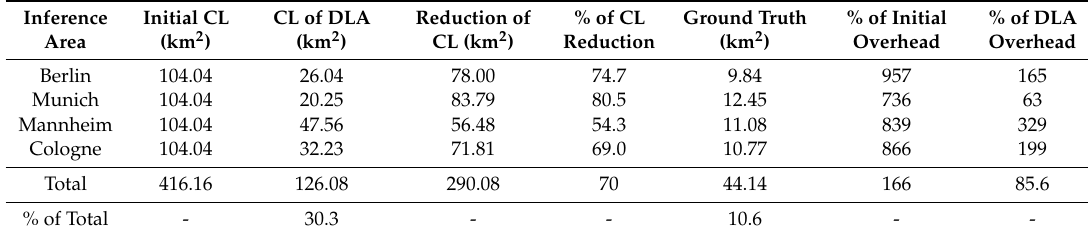
Table 2. DLA results on cognitive load (CL), ground truth, and work overhead compared to the initial task.